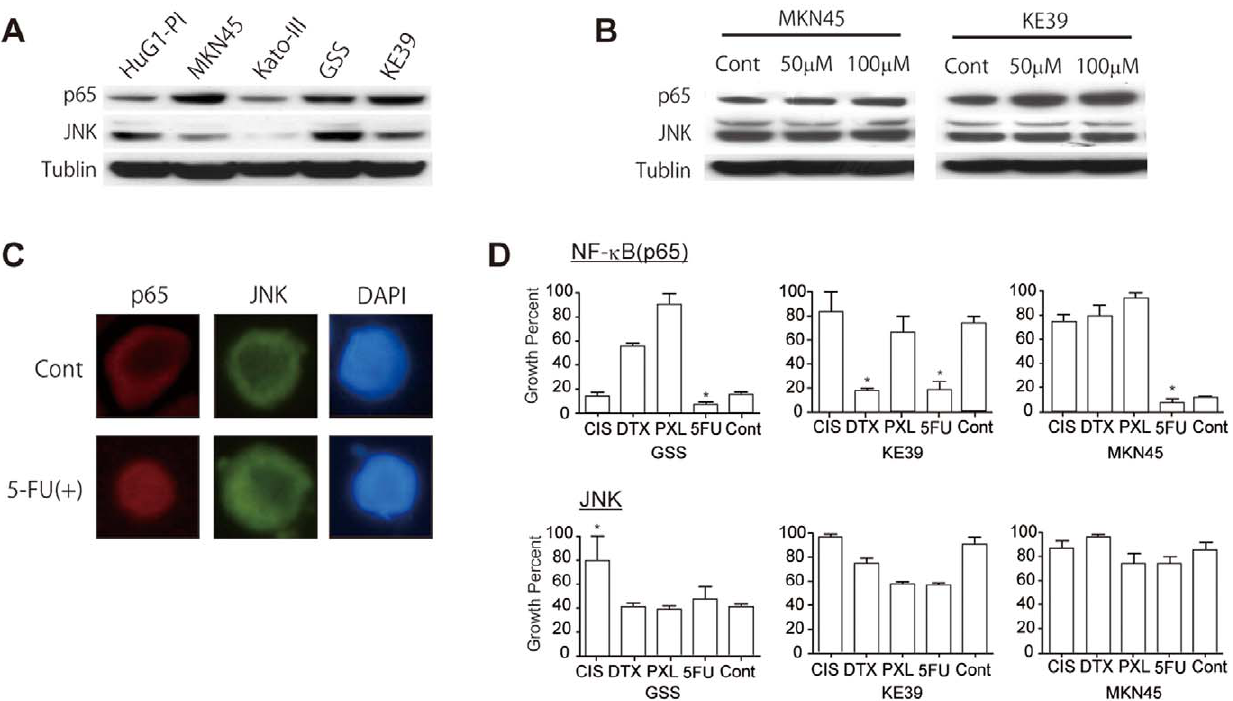
Figure 3. Induction of biomarkers by 5-FU treatment. (A) Baseline protein expression of NF- k B and JNK in five gastric cancer cell lines. Tublin was used as a loading control. (B) Induction of candidate biomarkers in response to 5-FU treatment in different concentrations in MKN45 and KE39. (C) Examination of protein localization by fluorescent immunocytochemistry using MKN45. (D) Increased inhibitory growth effect by anticancer agents in gastric cancer cell lines after transfection of siRNA for NF- k B p65 and JNK transcripts. Control samples are the corresponding cell lines transfected with the indicated siRNAs without anticancer agents. Abbreviations are: CIS, cisplatinum; DTX, docetaxel; and PXL, paclitaxel; and 5FU, 5- fluorouracil. * p , 0.05, Student t -test.